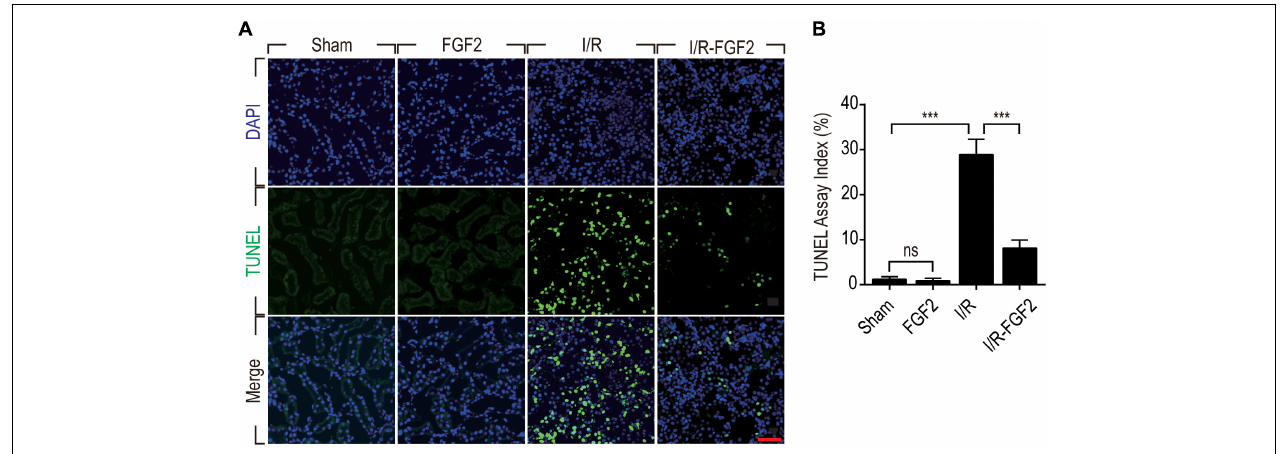
FIGURE 2 | Fibroblast growth factor 2 inhibits cell death in kidneys caused by I/R injury. (A) Representative sections of kidney tissues 24 h after reperfusion for the detection of nuclear DNA fragmentation performed by terminal deoxynucleotidyltransferase-mediated dUTP nick-end labeling (TUNEL) staining. Images are representative of five animals in each group. Scale bar represents 50 µ m. (B) Quantitative analysis of the number of TUNEL-positive renal tubular cells in kidney of each group: 1.18% in the Sham group, 0.89% in the FGF2 group, 28.89% in the I/R group, and 8.15% in the I/R-FGF2 group. FGF2 treatment dramatically decreases the proportion of TUNEL-positive cells in kidney tissues 24 h after reperfusion. Representative data of five individual samples in each group. *** P < 0.001; ns indicates not statistically significant.